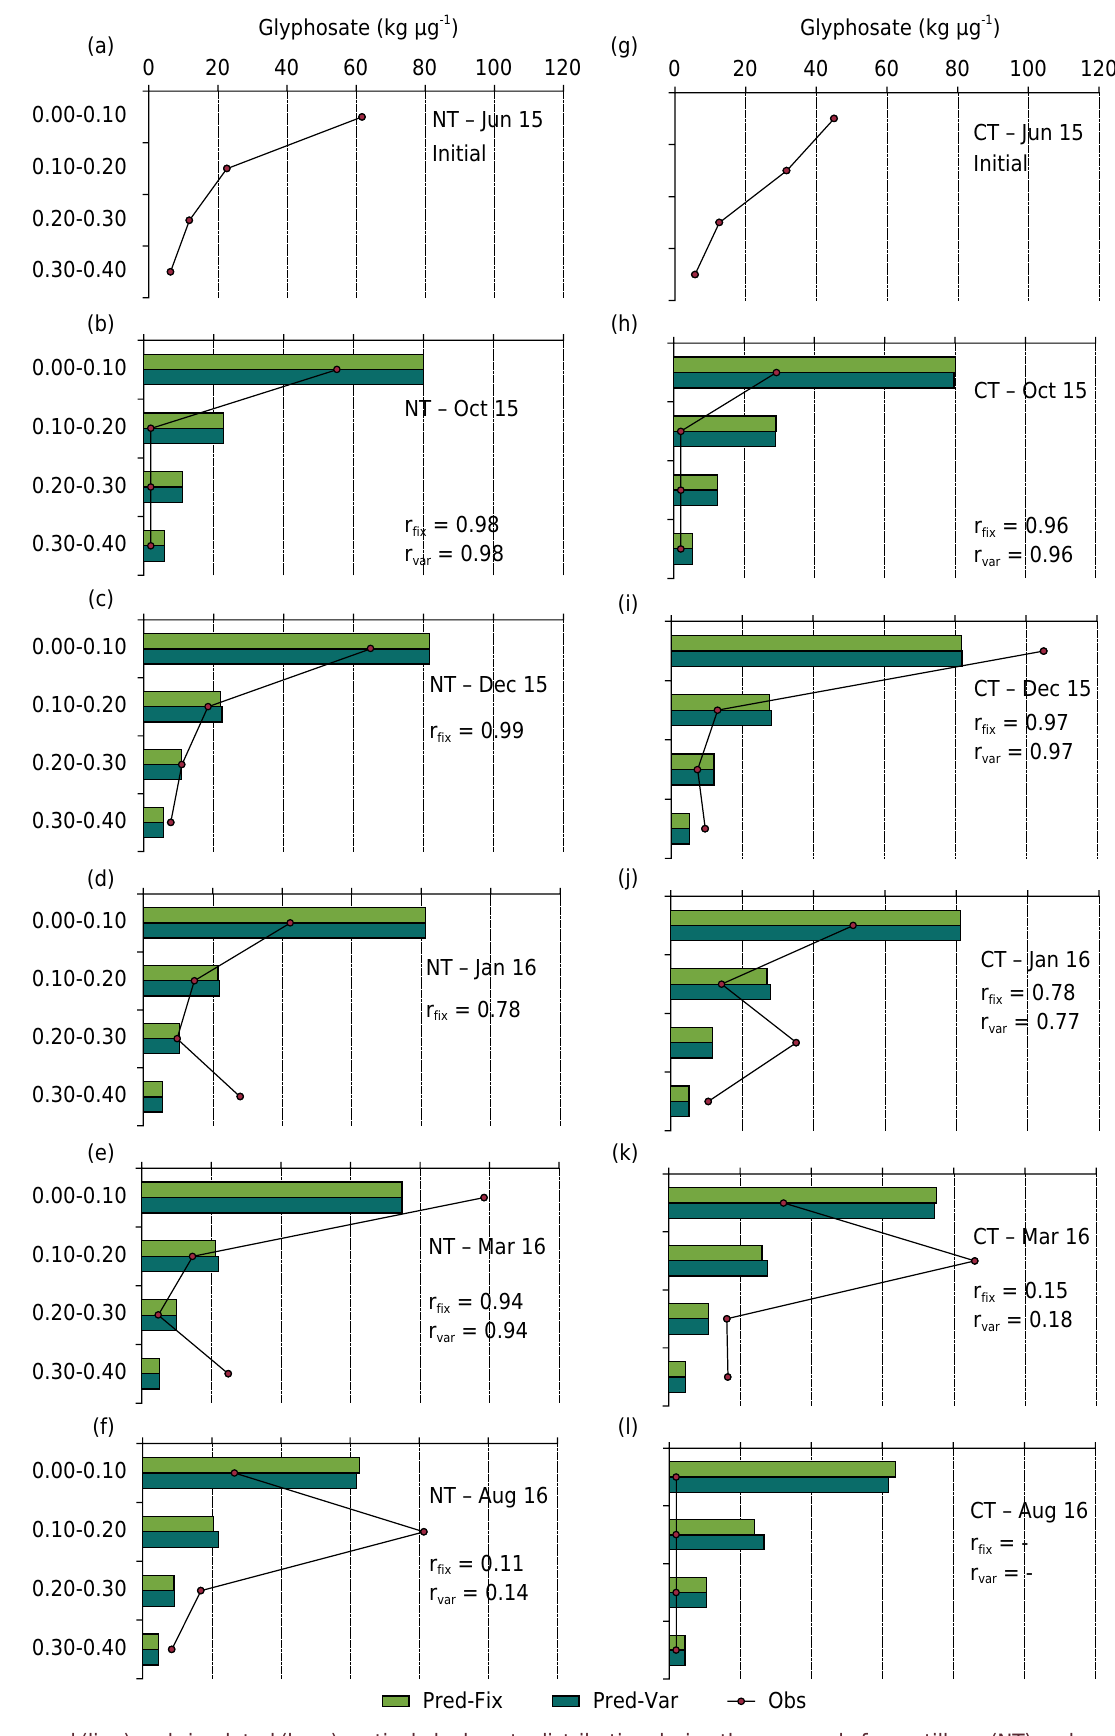
Figure 2. Observed (line) and simulated (bars) vertical glyphosate distribution during the crop cycle for no-tillage (NT) and conventional tillage (CT) using constant (Pred-fix) and time variable (Pred-var) hydraulic parameters. Tillage operation for CT treatment was carried out on September 30th,